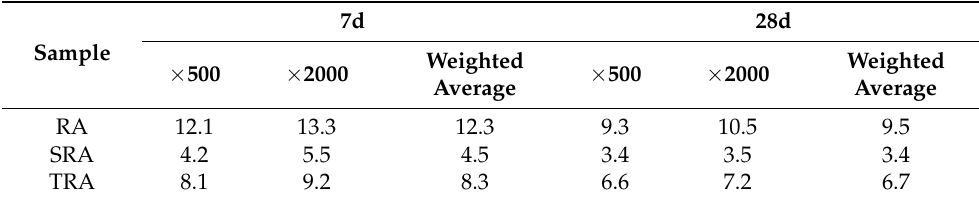
Table 8. Porosity of RA, SRA, and TRA